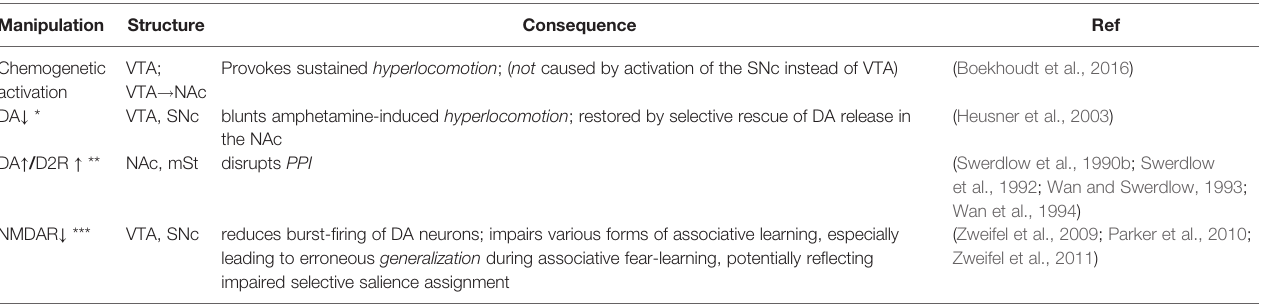
TABLE 2 | Experiments demonstrating the dependence of hyperlocomotion, pre-pulse inhibition (PPI), and salience attribution on striatal dopamine. Manipulation Structure